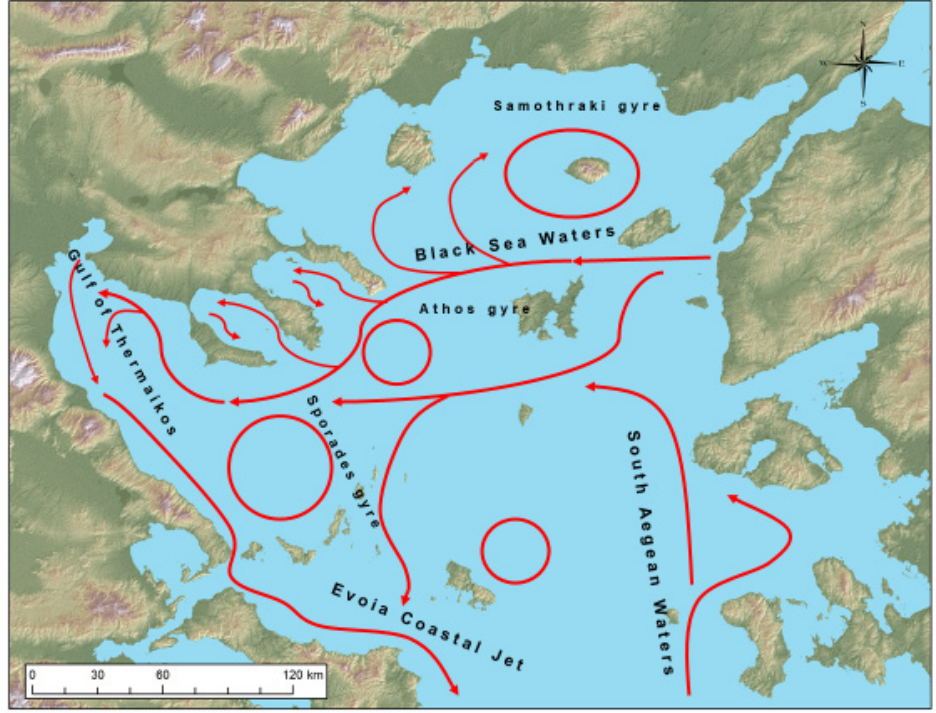
Figure 1. Study Area, the North Aegean Sea, Greece. All major oceanographic processes are mapped, the Black Sea Water driven circulation, the inflow from Southern Aegean and Gulf of Thermaikos and their interactions (adapted from [26,27]).